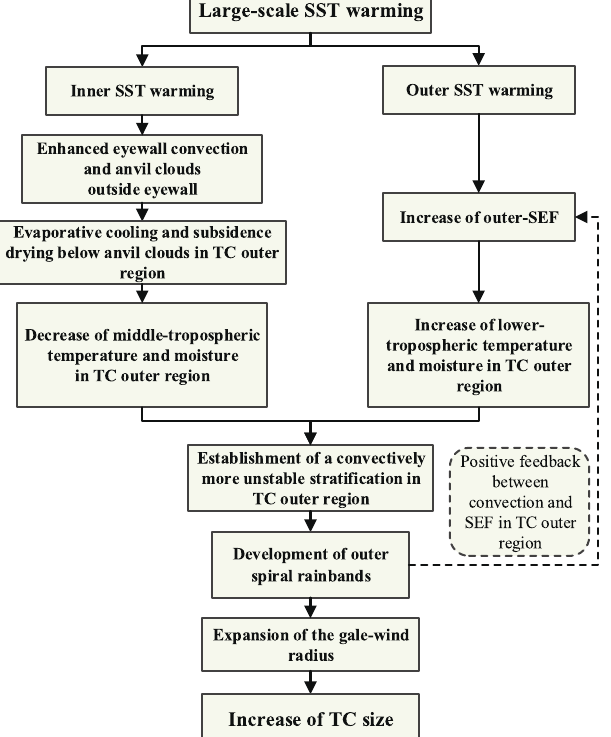
Figure 4. Schematic diagram summarizing the possible mechanisms responsible for the impact of large-scale SST warming on TC